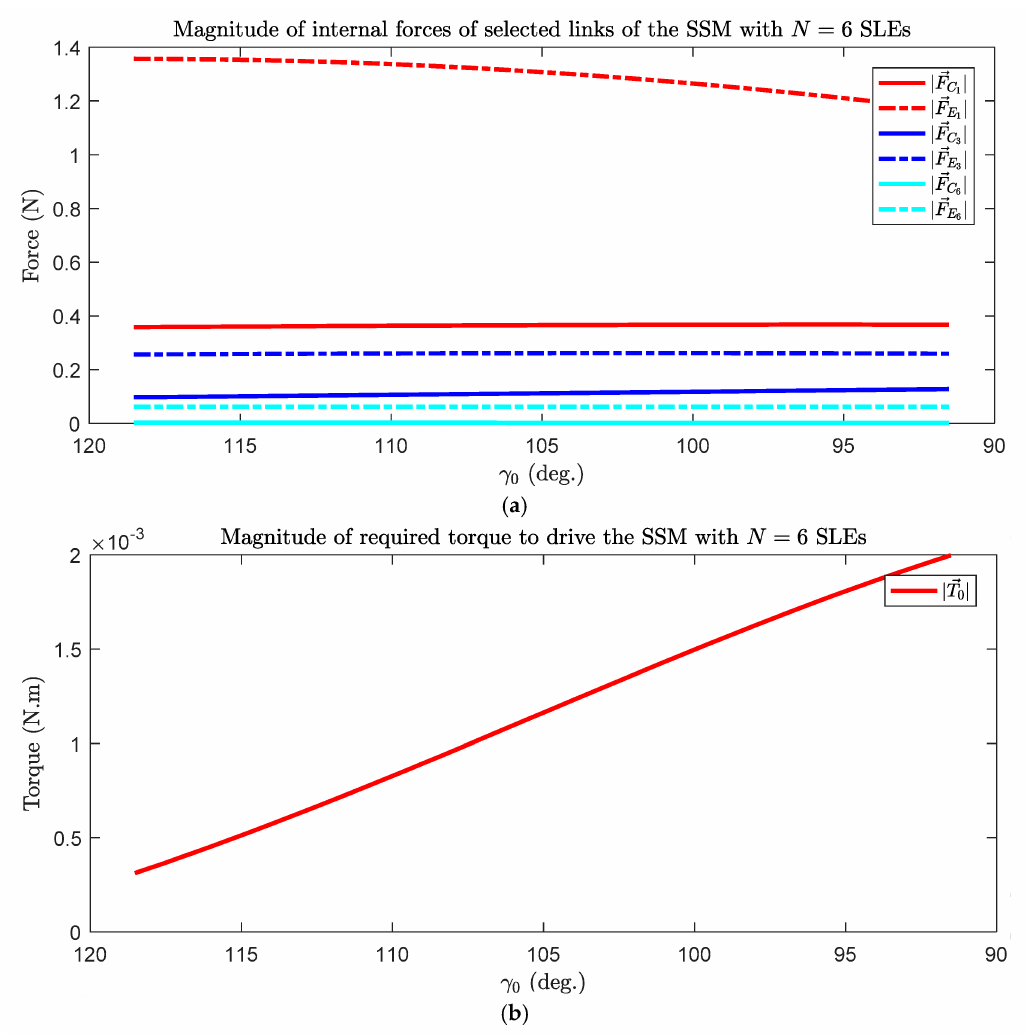
Figure 10. ( a ) Magnitude of internal forces of selected links of the SSM and ( b ) Magnitude of required torque to drive the SSM with N = 6 SLEs for NACA